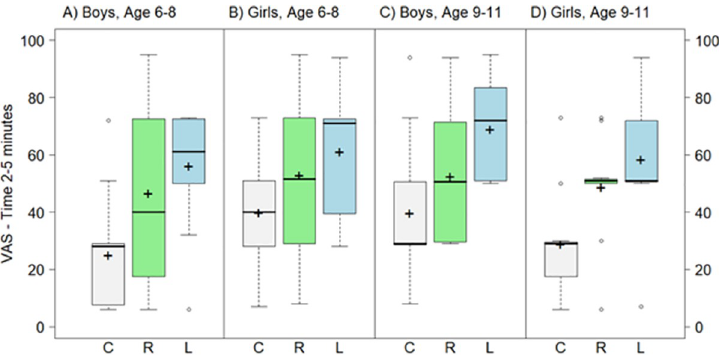
Fig 6. Boxplot of VAS scores (mm) for L-PZQ ODT (L) and Rac-PZQ ODT (R) dispersed with water and current PZQ-Cesol (C) crushed in water at time 2–5 minutes, by gender and age. Dark lines indicate median values; ’+’ indicate mean values; the boxes represent the middle 50% of data with the bottom and top of the box represent the first and third quartiles (interquartile range, IQR); the whisker lines above and below the boxes represented the largest and smallest values that are not considered to be outliers; outliers are values that are 1.5 times the IQR below the first quartile or above the third quartile and are denoted with an open